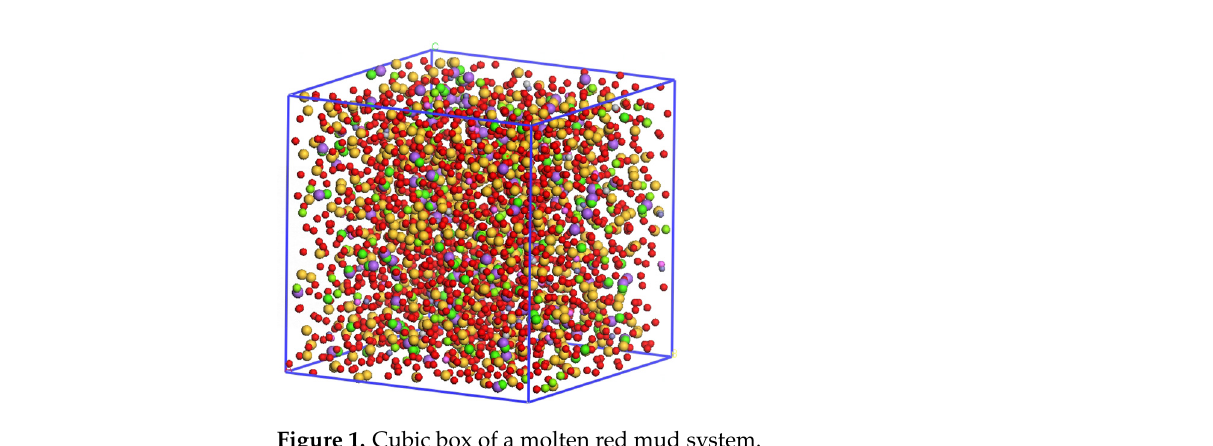
Figure 2. Computing process of simulation. Table 2. Composition of red mud and number of atoms. Figure 1. cubic box of a molten red mud system.